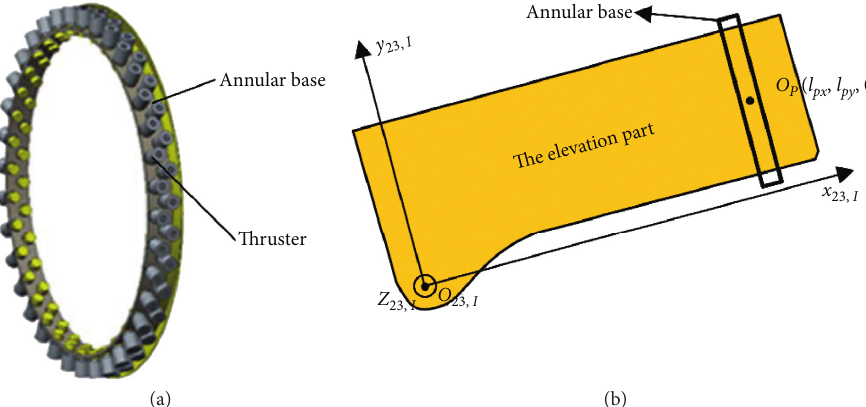
Figure 2: The design of the AAT: (a) the structure and (b) the location.